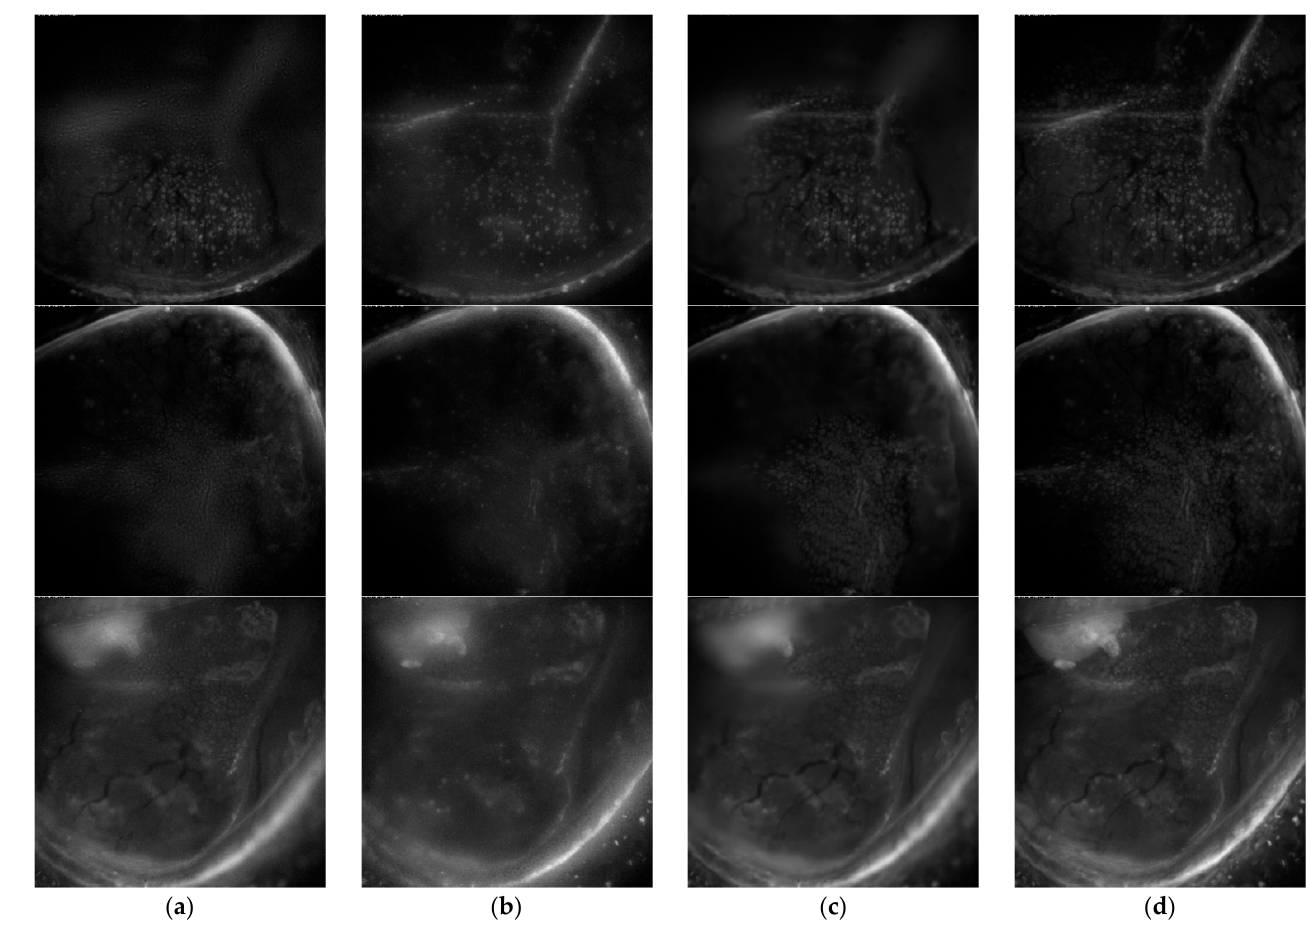
Figure 7. Conjunctival goblet cell, fused image results from different methods. ( a ) DWT, ( b ) quad-tree, ( c ) GFDF, and the ( d ) proposed method.